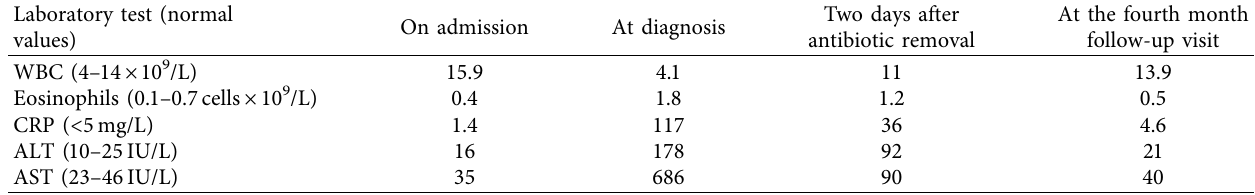
Table 2: Te trend in relevant laboratory fndings in our patient during hospitalization and after discharge.